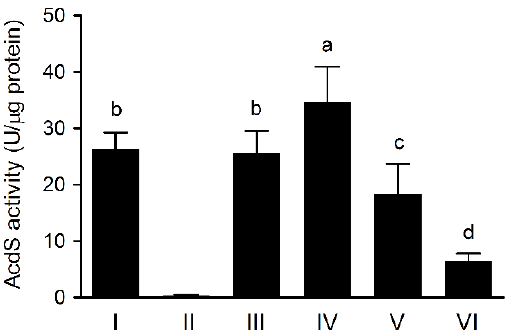
Figure 2. The AcdS activities of Pseudomonas sp. UW4 and derivative strains cultivated in LB medium plus ACC for 10 h. Note: Same as Figure 1.